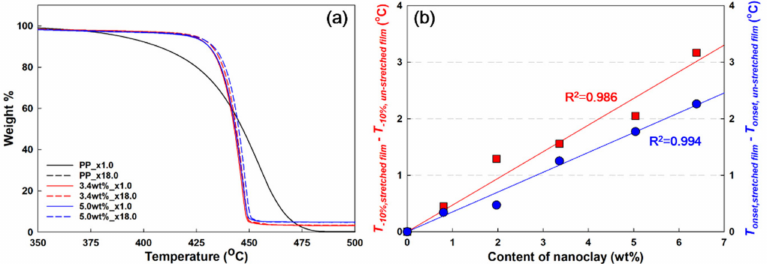
Figure 5. ( a ) Thermogravimetric (TG) curves and ( b ) difference in values (T − 10% and T onset ) of unstretched films ( × 1.0) and stretched films ( × 18.0) of neat PP and PP/nanoclay